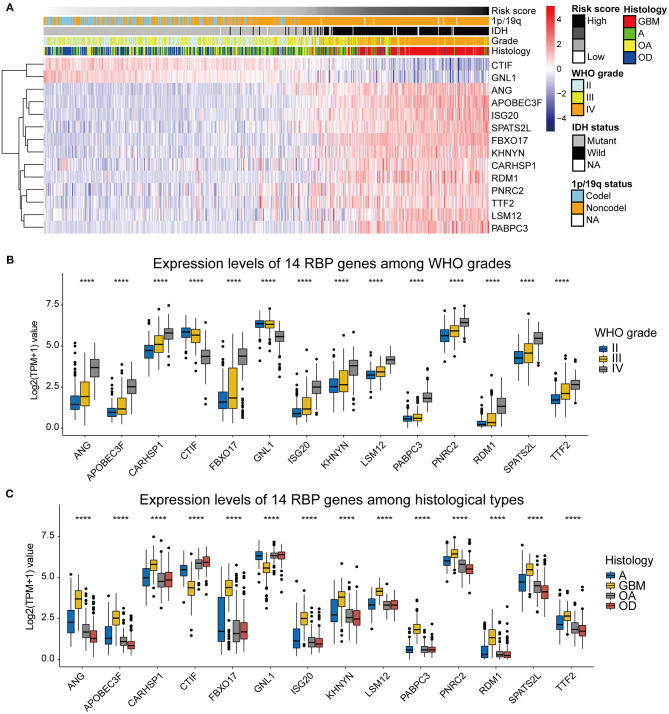
(A) The heatmap showing the correlation between the expression levels of the 14 RBP genes and the clinicopathological features including the risk score, 1p/19q codeletion status, IDH mutational status, WHO grade, and histological types. (B) Expression levels of the 14 RBP genes among gliomas with different WHO grades. (C) Expression levels of the 14 RBP genes among gliomas with different histological types. GBM, glioblastoma; A, astrocytoma; OA, oligoastrocytoma; OD, oligodendroglioma. *p < 0.05, **p < 0.01, ***p < 0.001, ****p < 0.0001.